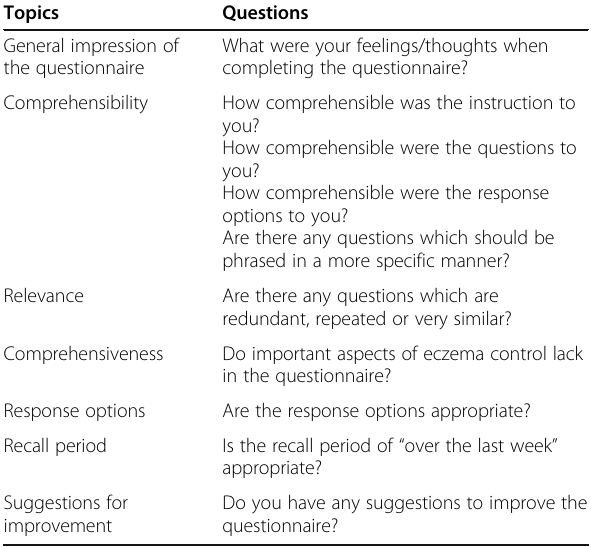
Table 1 Topics covered in the interview guide [1, 14]